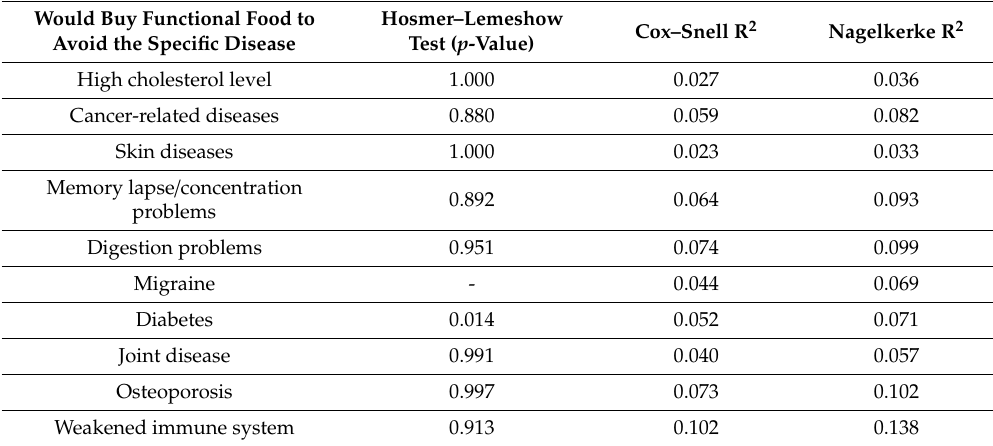
Table A1. Goodness of fit tests of